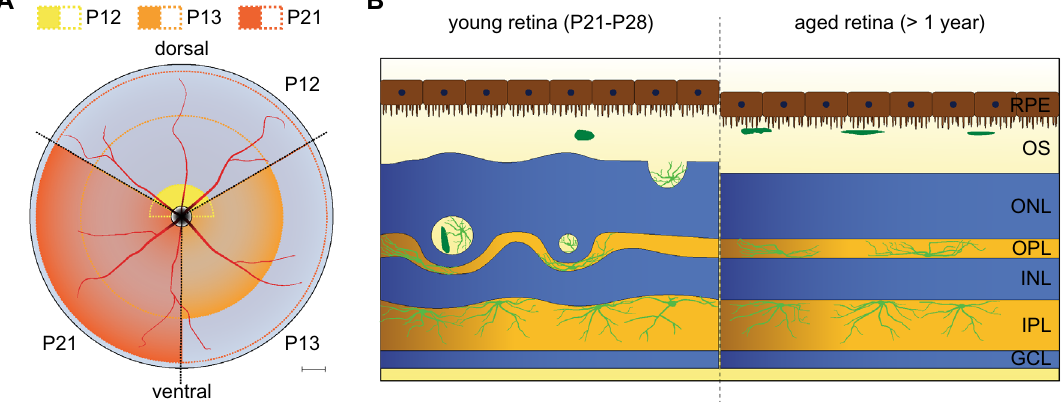
Figure 8. Disease mechanisms in C57BL/6J Nr2e3 rd7/rd7 mice. Schematic drawing of disease mechanisms in the C57BL/6J Nr2e3 rd7/rd7 mouse model of ESCS. ( A ) Early postnatal steps in ‘rosette’ formation. At P12, ‘rosettes’ appear dorsally (yellow), at P13 a pan-retinal expansion towards the periphery is observed (orange), and at P21 ‘rosettes’ have expanded to the far periphery. Scale bar: 250 µM. ( B ) Inflammatory cell population in young and aged C57BL/6J Nr2e3 rd7/rd7 retinas. At P21 and P28 activated microglial cells (light green) migrate into the rosettes and few monocyte/macrophage-derived cells (dark green) are present in the retina. In aged retinas, the outer nuclear layer is thinning and subretinal macrophages (dark green) are regularly spaced in the